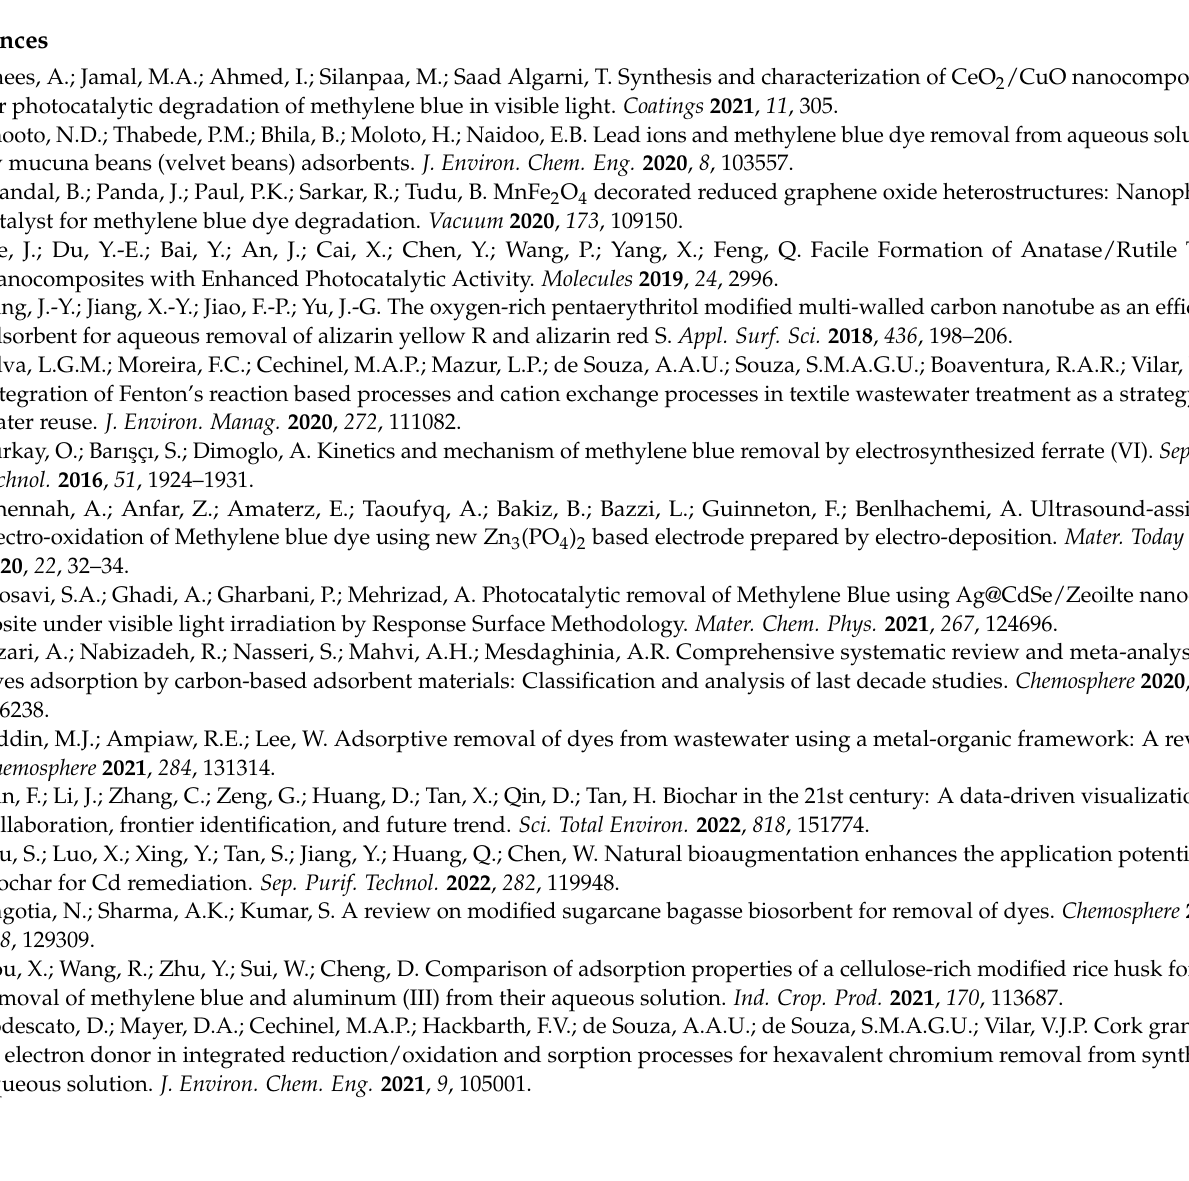
CPP200; Table S1: Adsorption kinetic parameters for the adsorption of MB onto CPP200; Video S1: title; Table S2: Adsorption isothermal parameters for the adsorption of MB onto CPP200; Table S3: Thermodynamic parameters of MB adsorption onto CPP200; Table S4: Molecular structure, molecular weight and maximum absorbance of